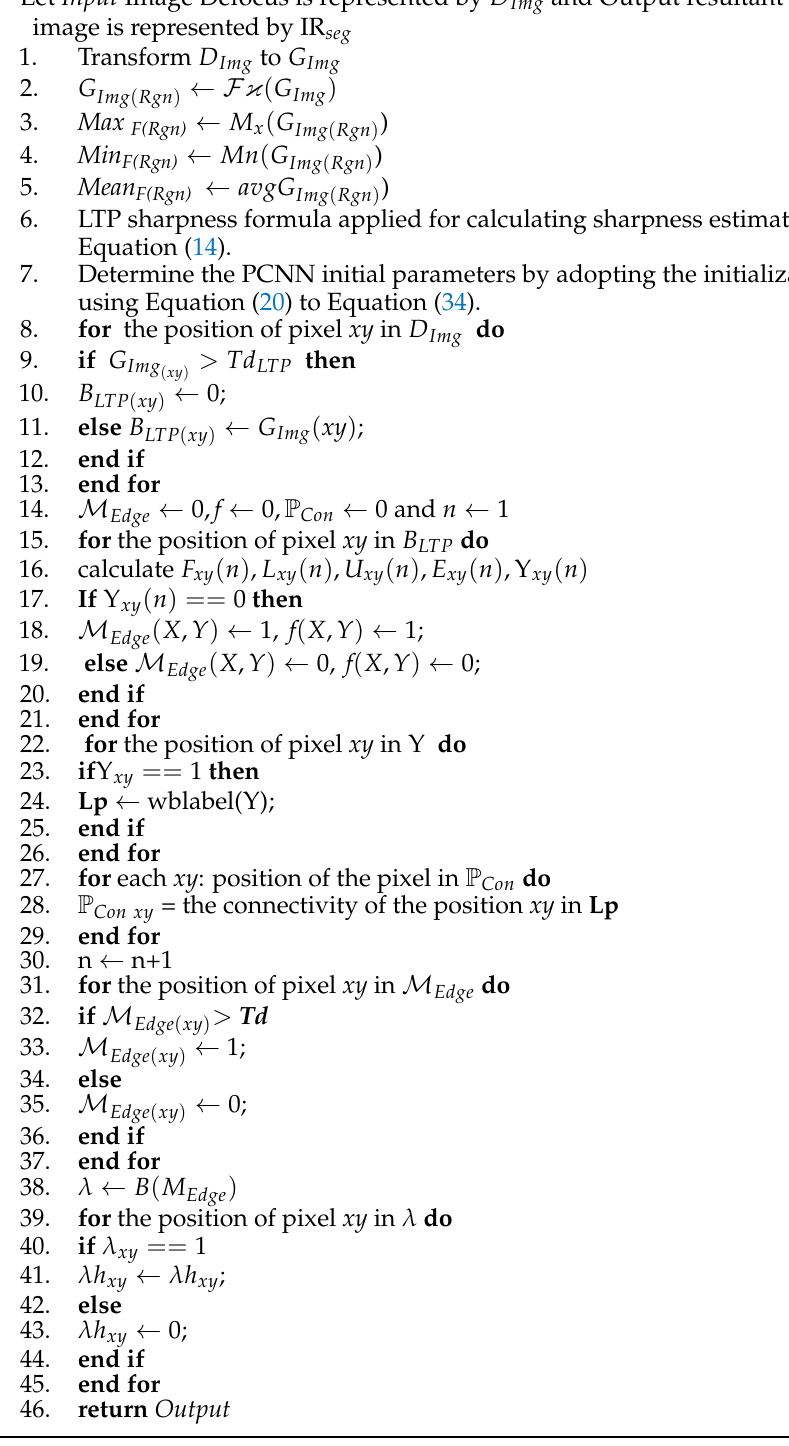
Algorithm 1: Defocus Blur Segmentation